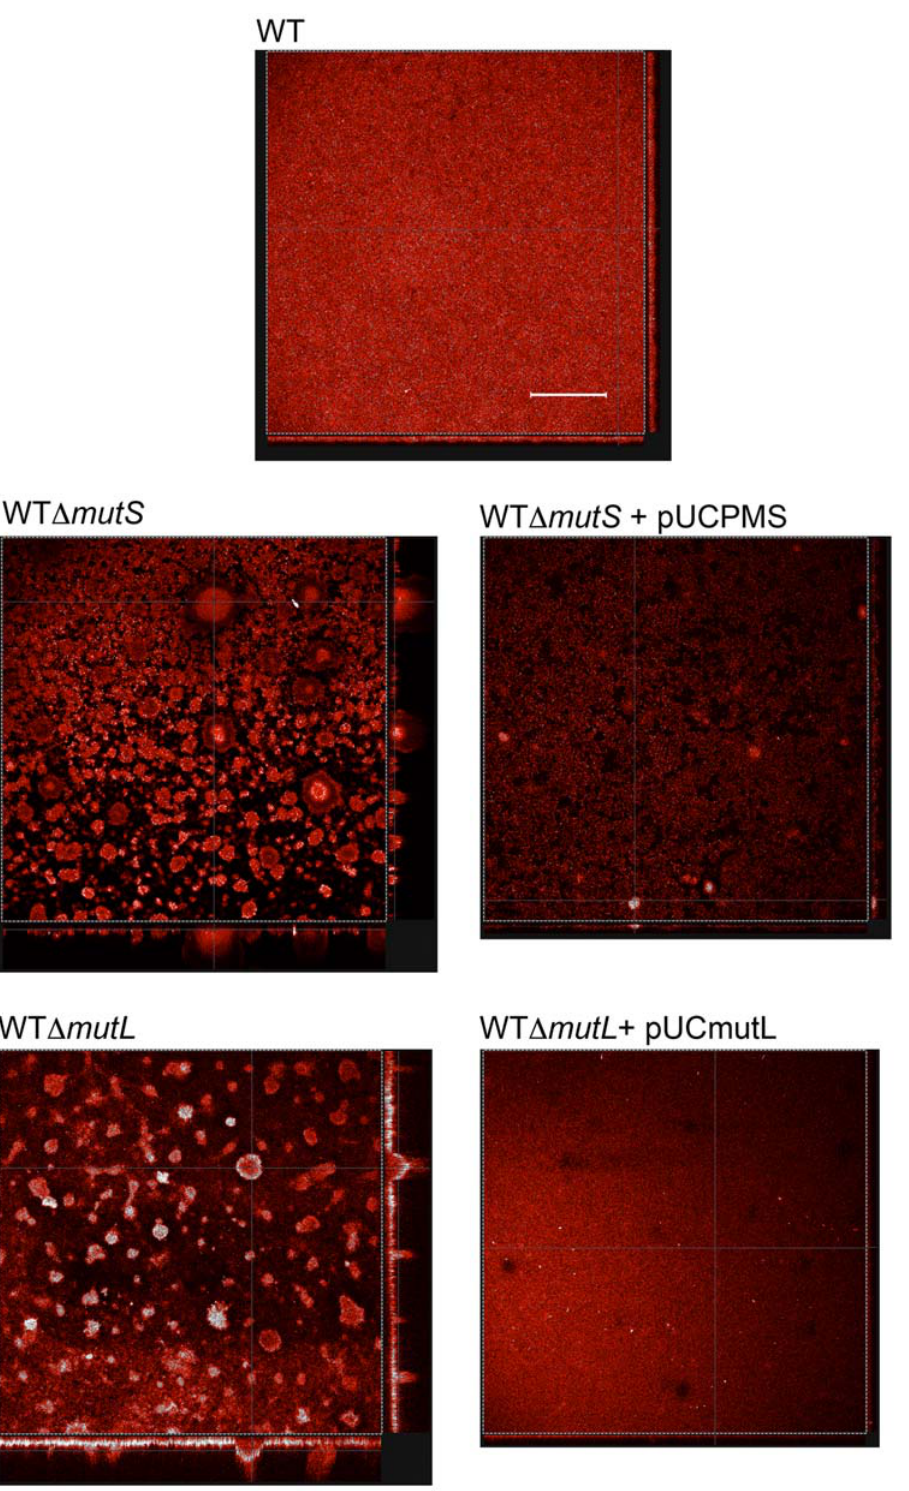
Figure 3. Representative confocal scanning laser microscopy images showing biofilms of P.aeruginosa wild-type, D mutS , D mutL and complemented strains after 10 days of biofilm development. The central images show a top-down view of the biofilm; side panels are vertical sections. Scale bar represents 150 m m.